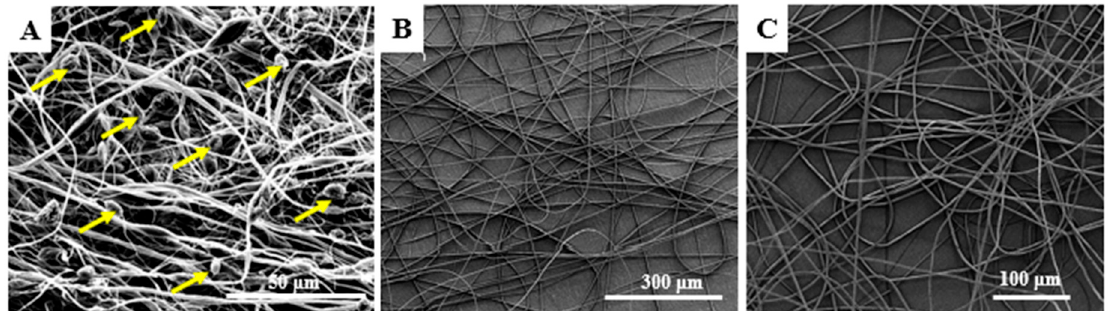
Figure 1. SEM images of electrospun scaffolds arose from a solution of THF/DMF (80/20 w / w ) solvent mixture with pure PEI at the amount of ( A ) 10 wt %, ( B ) 15 wt %, and ( C ) 20 wt % respectively (yellow darts: bead formation).